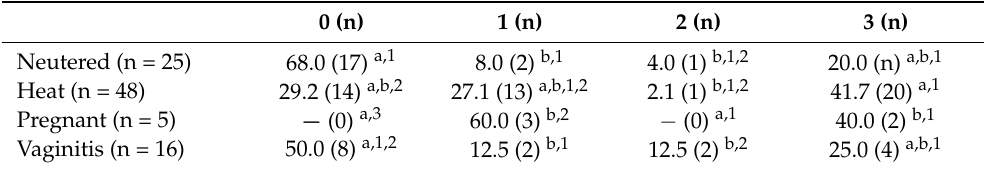
Table 7. Quantification in terms of percentages of vaginal LAB from bitches included in the study (n). Females were distributed into four groups, namely neutered, in heat, pregnant and with vagini- tis. Different letters mean significant differences ( p ≤ 0.05) between columns within a given row. Different numbers mean significant differences ( p ≤ 0.05) between rows within a given